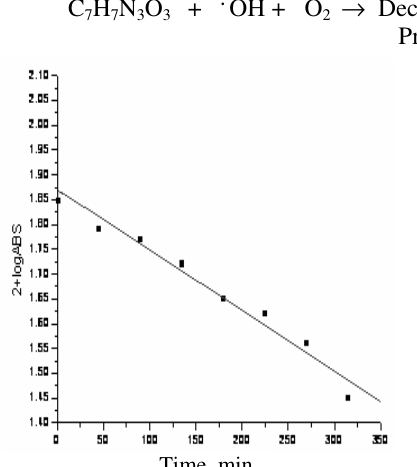
Figure 1. (Typical Run) Degradation of